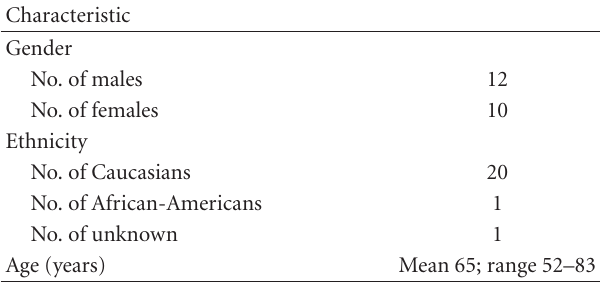
Table 1: Demographic characteristics of study subjects.